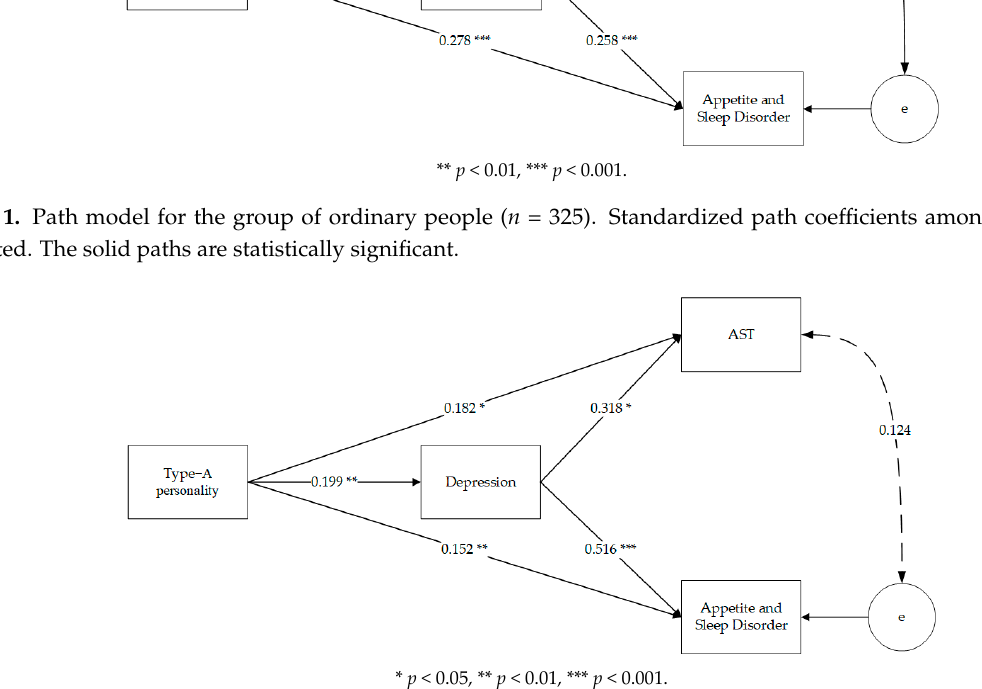
Figure 2. Path model for the frontline anti-epidemic medical staff sample ( n = 310). Standardized path coefficients among variables are presented. The solid paths are statistically significant.